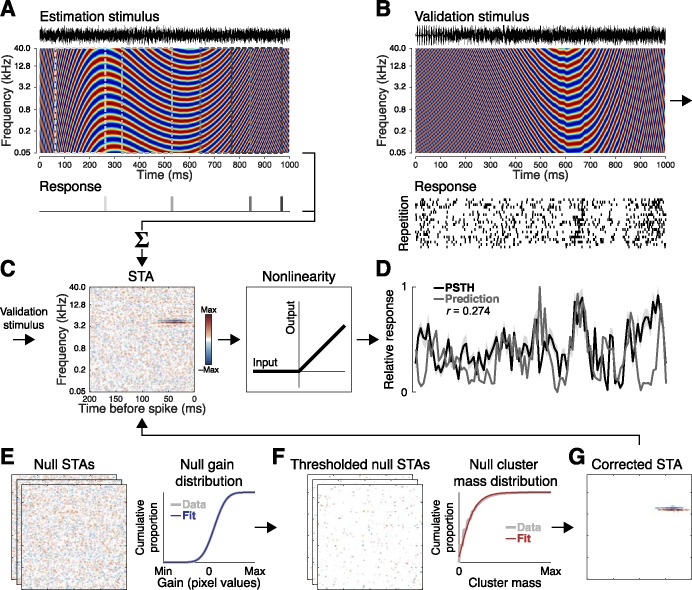
Spectrotemporal receptive field (STRF) estimation and validation procedures.(A) Units were first probed with a 30-min dynamic moving ripple (DMR), a synthetic broadband stimulus sharing many features with natural sounds including local spectrotemporal correlations. (B) Responses elicited by a novel 30-s DMR segment (50 repetitions) were used for subsequent validation and testing. (C) STRFs were estimated by calculating the spike-triggered average (STA). Response predictions were obtained by convolution of the STRF and validation spectrogram, with the output nonlinearity modeled by half-wave rectification. (D) STRF validity was assessed by calculating the correlation coefficient between predictions and neuronal responses obtained with the trial-averaged peristimulus time histogram (PSTH). (E) Null STAs computed with circularly-shifted spike times were used to generate a sample of gain values expected by chance. A normal distribution fit to these values was used to determine gain value cutoffs corresponding to a logarithmically-spaced range of significance levels from p < 100 to p < 10−9. (F) Similarly, null STAs subjected to a gain threshold were used to generate a sample of cluster mass values expected by chance, and a gamma distribution fit to these values was used to identify cluster mass cutoffs corresponding to the same range of significance levels. (G) The corrected STA was defined by pixels (clusters) exceeding a specified significance level.